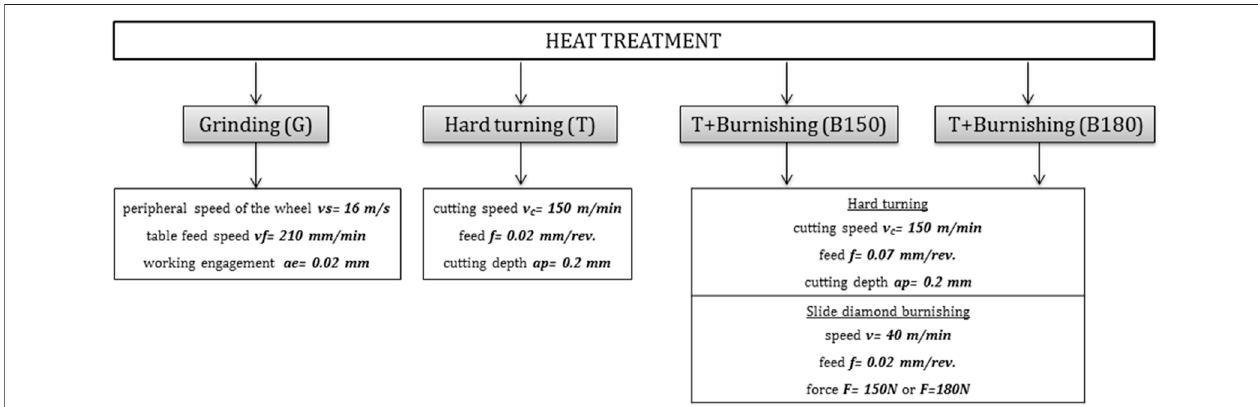
FIGURE 2 | Types of mechanical surface treatments with